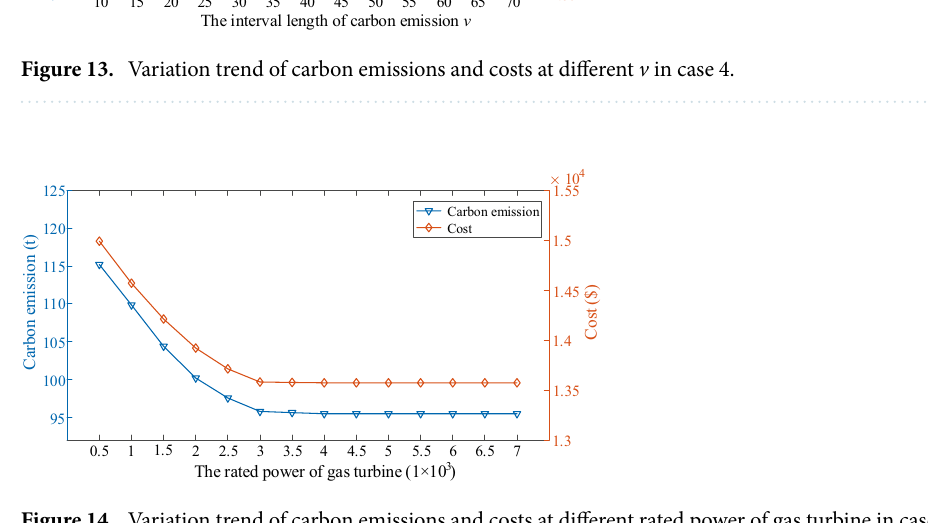
Figure 14. Variation trend of carbon emissions and costs at different rated power of gas turbine in case